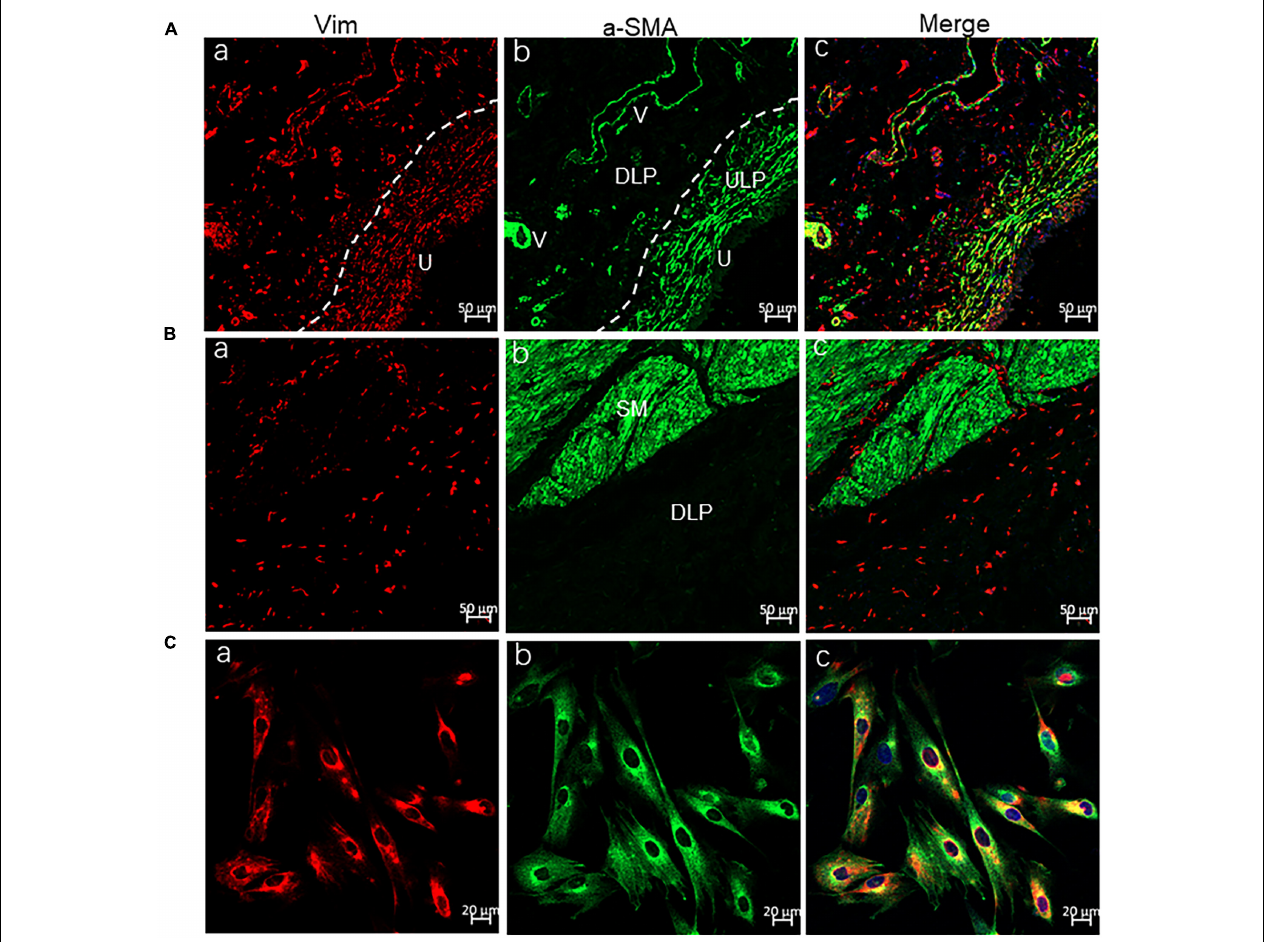
FIGURE 1 | Confocal immunofluorescence for Vim (red) and α -SMA (green) showing ULP-ICs and cultured ICs having the phenotype of Vim+ α -SMA+. (A,B) Immunofluorescence of the bladder wall showing Vim+ (red) ICs distributed in the ULP [ (Aa) , densely packed cells immediately beneath the urothelium], DLP [ (Ba) , loosely distributed between the ULP and detrusor] as well within or between the detrusor muscle (Ba) . Vim+ staining is also seen in endothelial cells of blood vessels (V). α -SMA+ (green) staining is present on ULP-ICs (Ab) and the detrusor muscle [SM, (Bb) ] but not on DLP-ICs or detrusor-ICs (Bb) . Perivascular smooth muscle also expresses α -SMA. Co-expression of Vim and α -SMA is shown in merged images (Ac and Bc) . (Ca–Cc) Immunofluorescence of Vim and α -SMA in cultured LP-ICs showing most of the Vim+ ICs are α -SMA+. DLP: deep lamina propria; ULP: upper lamina propria; U: urothelium; V: vessels; SM: smooth muscle. Dashed line indicates the transition between the ULP and